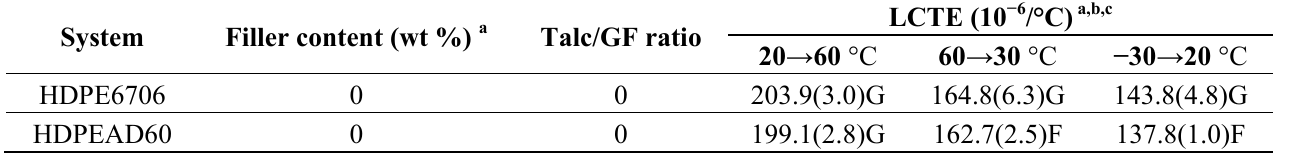
Table 4. Summary of thermal expansion properties of virgin HDPE and filled HDPE Composites with combined glass fiber and talc